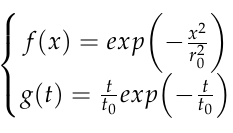
Figure 4. ( a ) M8 bolt with a smart piezoelectric sensor; ( b ) ultrasonic signal strength for different spot diameters.